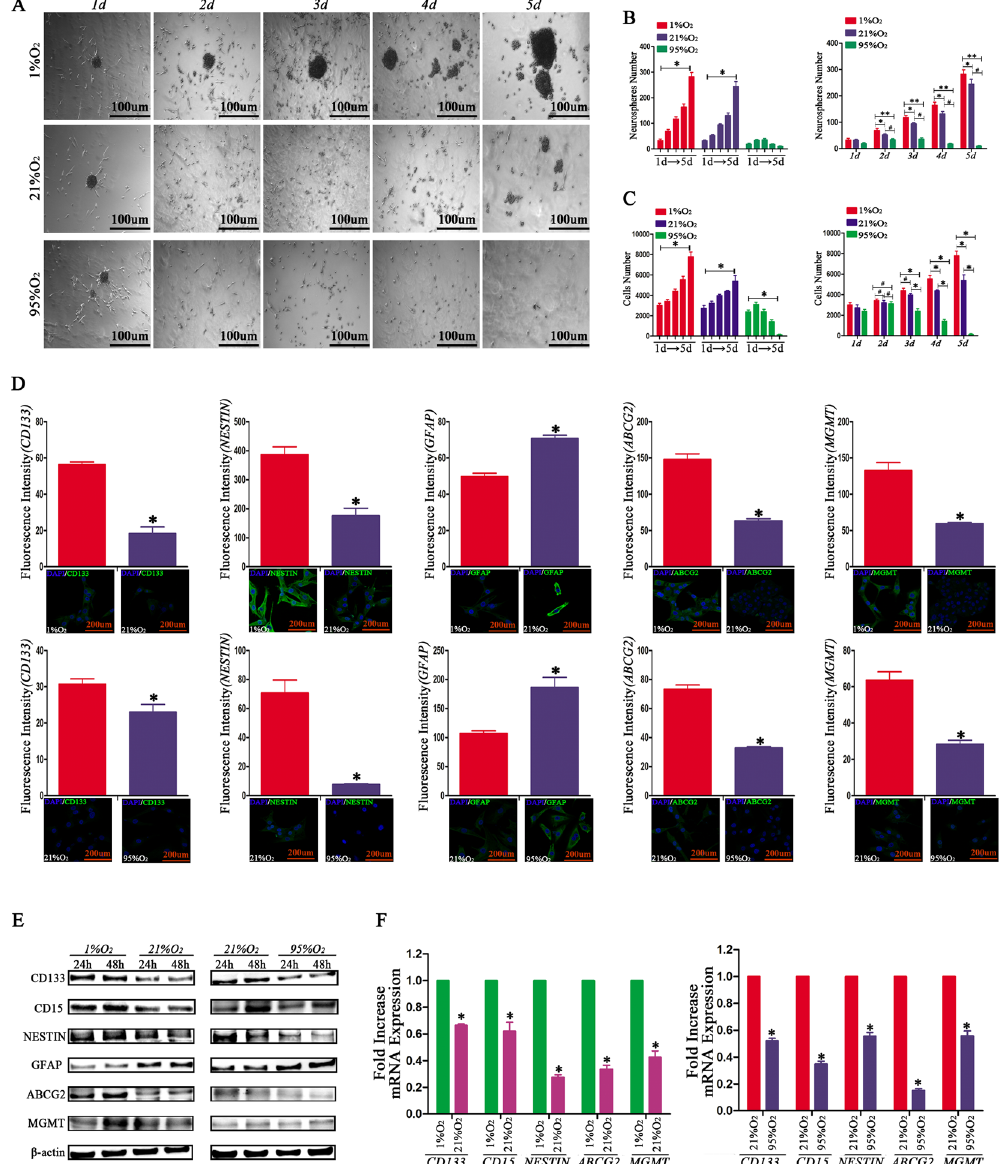
Figure 4. Neurospheres formed in 1%O 2 presented different growth styles under different oxygen levels. ( A ) U87 CD133 + CD15 + NESTIN + neurospheres maintained growth in suspension with a sphere morphology under 1%O 2 conditions; under 21%O 2 , some neurospheres also existed after exposure for 5 d. However, there were no neurospheres after 95%O 2 exposure for 5 d. ( B ) The number of neurospheres increased in a time-dependent manner from hypoxia exposure for 1 to 5 d; compared with 21%O 2 , the number of neurospheres in 1%O 2 was substantially increased, whereas under hyperoxic conditions, few neurospheres were detected ( * P < 0.05; ** P < 0.05; # P < 0.05, One-sample T Test, One-way ANOVA). ( C ) There were no differences among the different oxygen levels on day 2 for the cell number of U87 CD133 + CD15 + NESTIN + neurospheres. After three days, the number of cells under 95%O 2 gradually decreased. In contrast, the cell numbers in 1%O 2 and 21%O 2 increased in a time-dependent manner, and the cell proliferation rate of cells in 1%O 2 was faster than that of cells in 21%O 2 ( * P < 0.05; # P > 0.05, One-sample T Test, One-way ANOVA). ( D–F ) Hypoxia promoted the expression levels of CD133, CD15, NESTIN, ABCG2 and MGMT and inhibited GFAP for U87 CD133 + CD15 + NESTIN + stem cells. In contrast, hyperoxia presented the opposite effects, which resulted in decreases of CD133, CD15, NESTIN, ABCG2 and MGMT and an increase of GFAP ( * P < 0.05, Paired-samples T Cell cycle, apoptosis and IC50 detection of CD133 + /CD15 + /NESTIN + glioma neurospheres formed in 1%O . 2 indicated there were more cells arrested in G 0 /G 1 with rates greater than 60% for U87 CD133 + /CD15 + /NESTIN +